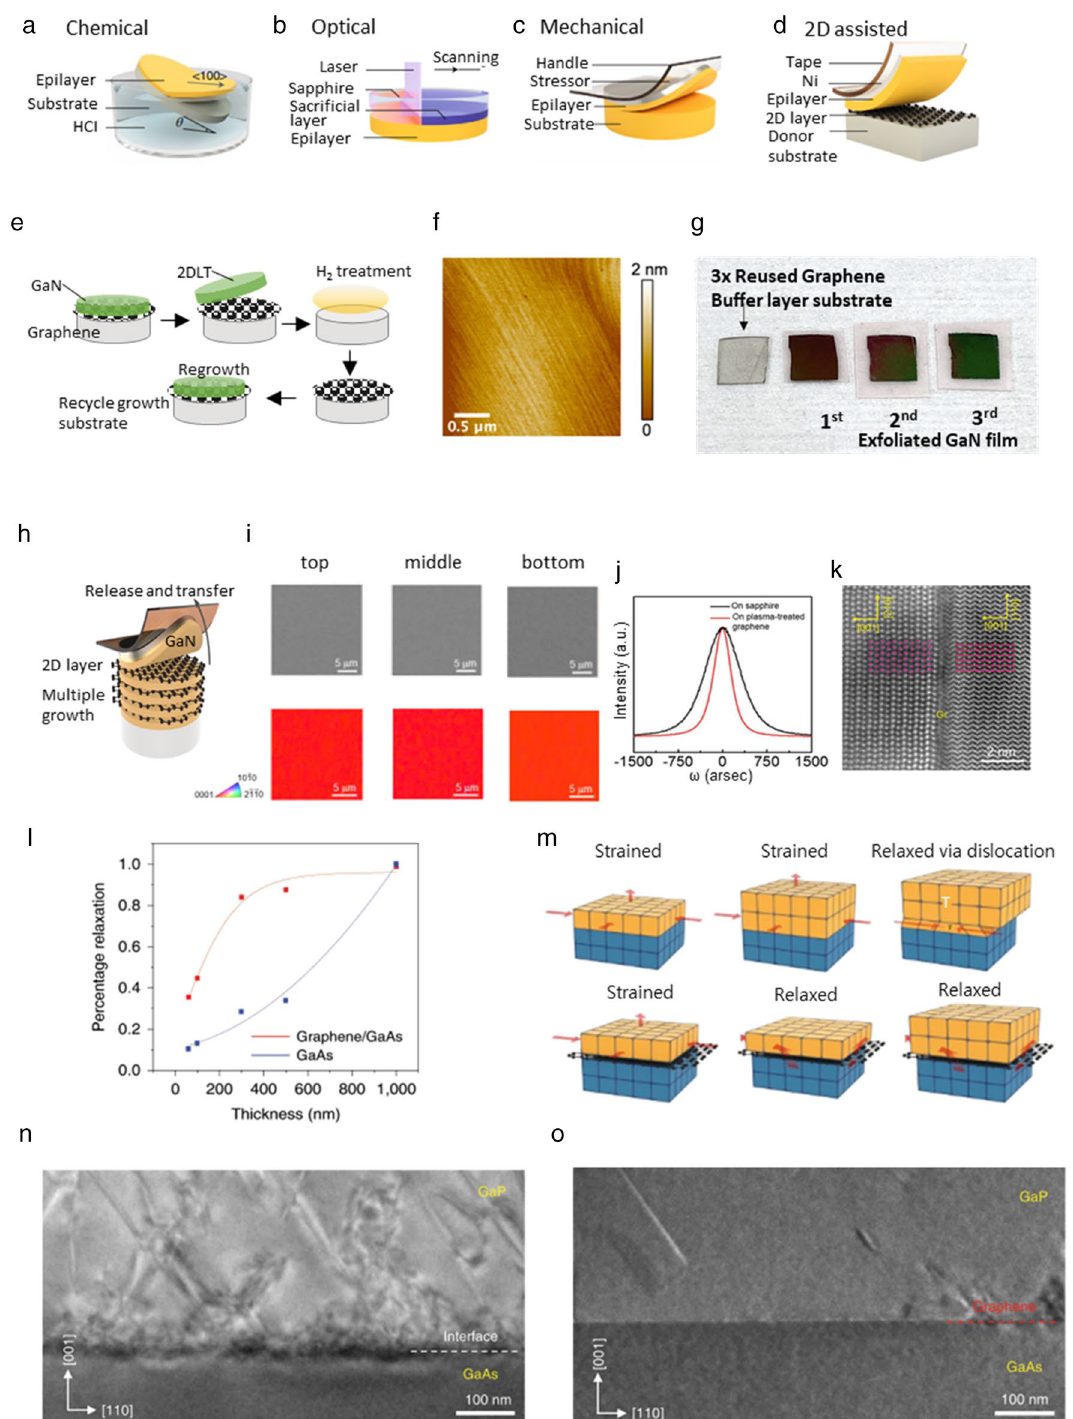
Fig. 2 (See legend on previous